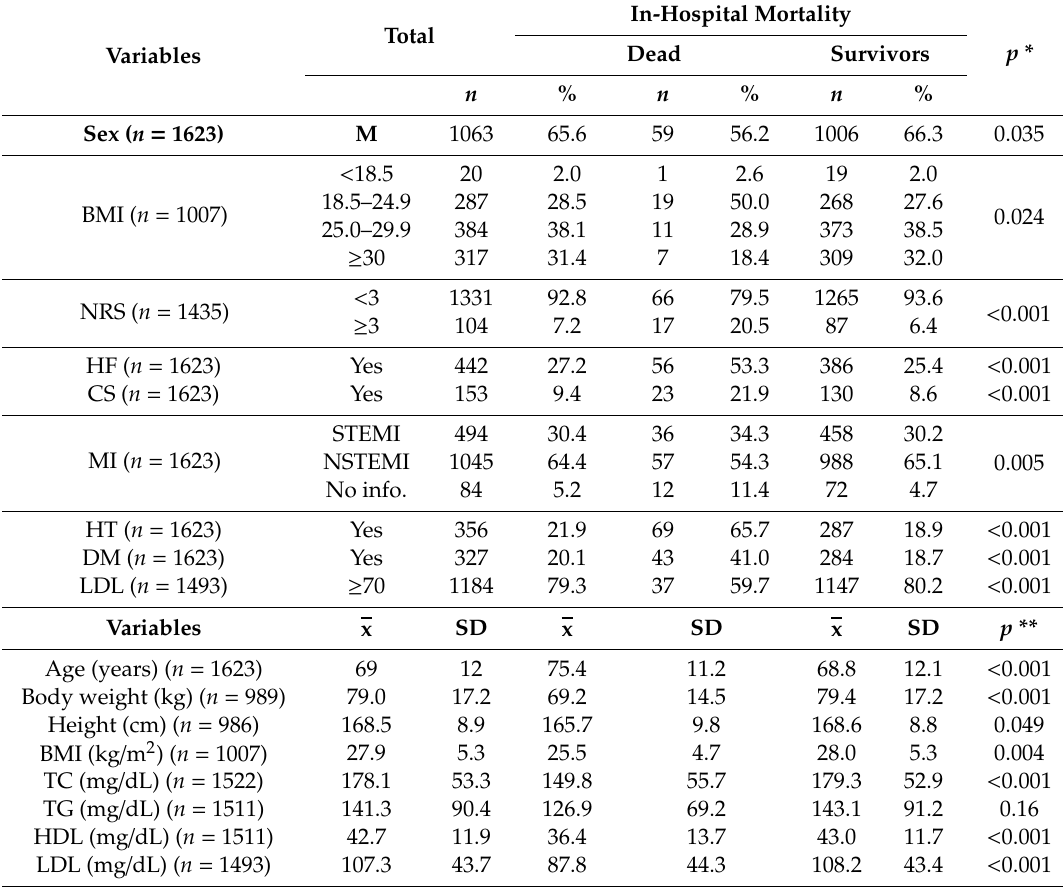
Table 1. Characteristics of the group with a comparison of survivors and dead patients.